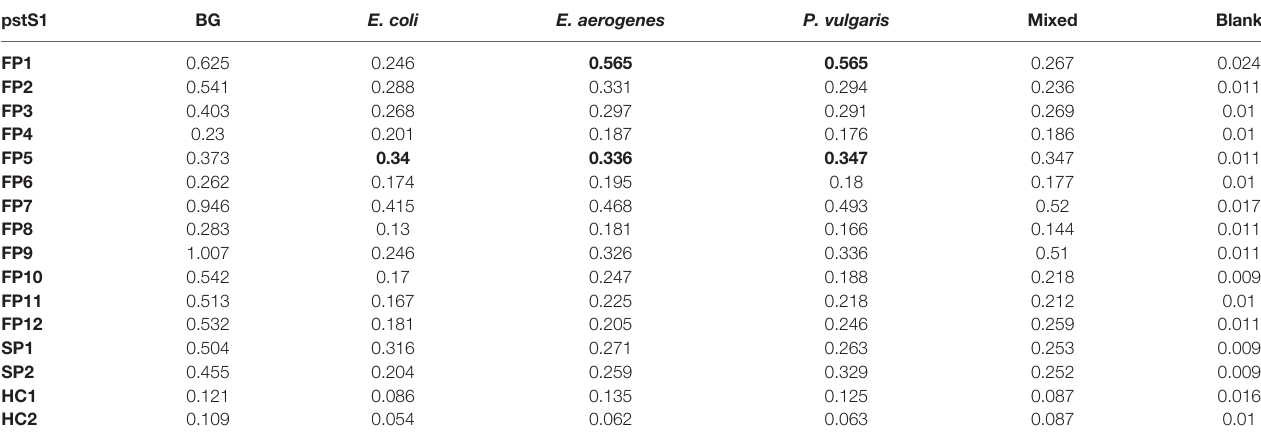
TABLE 2 | Comparison of the effect of pre-adsorption by P. vulgaris, E. aerogenes and E. coli ( for pstS1) . pstS1 BG E.